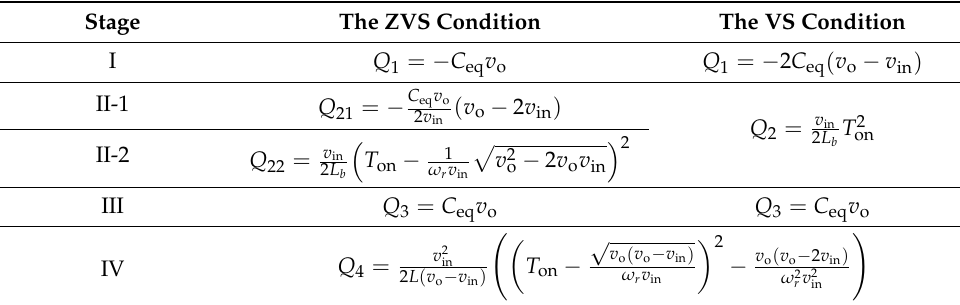
Table 3. Lists of the inductor charges during the